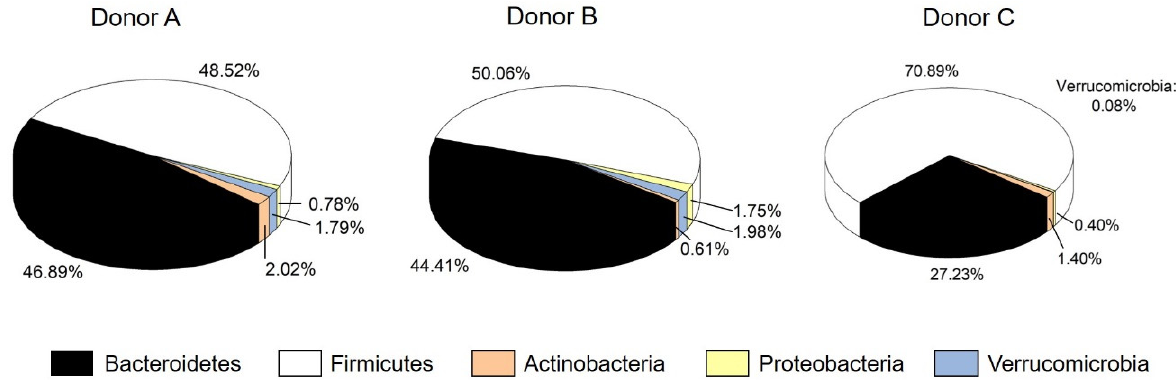
Figure 1. Relative cumulative abundance of the five major phyla in each stool sample.